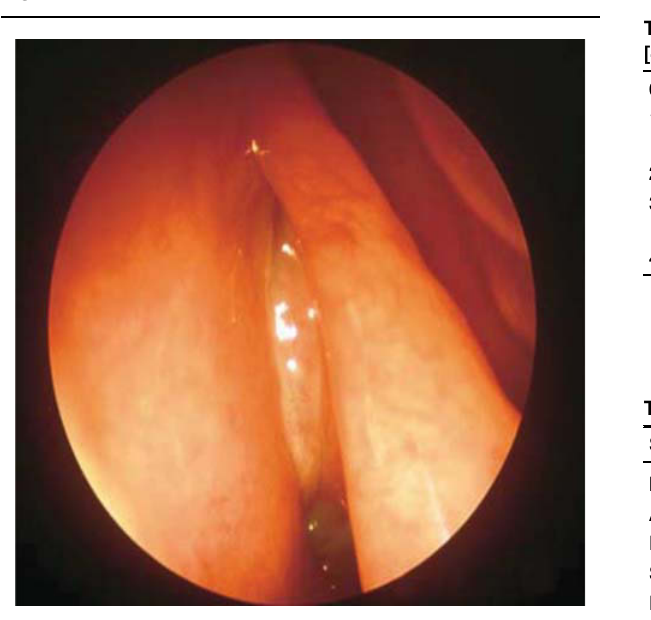
Right nasal cavity with a small polyp extending from the middle meatus (Meltzer